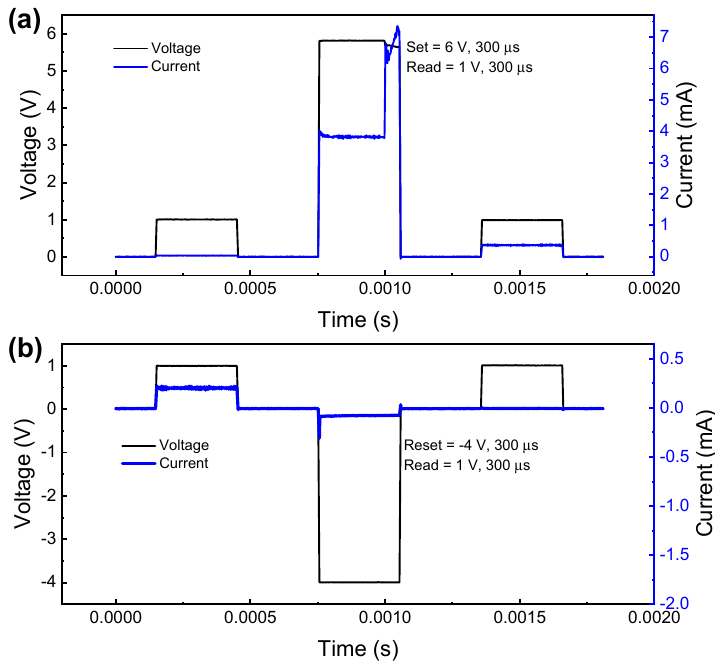
Figure 5. Pulse transient characteristics of Au/Ti/HfTiO x /p-Si device for ( a ) set process and ( b ) reset process.